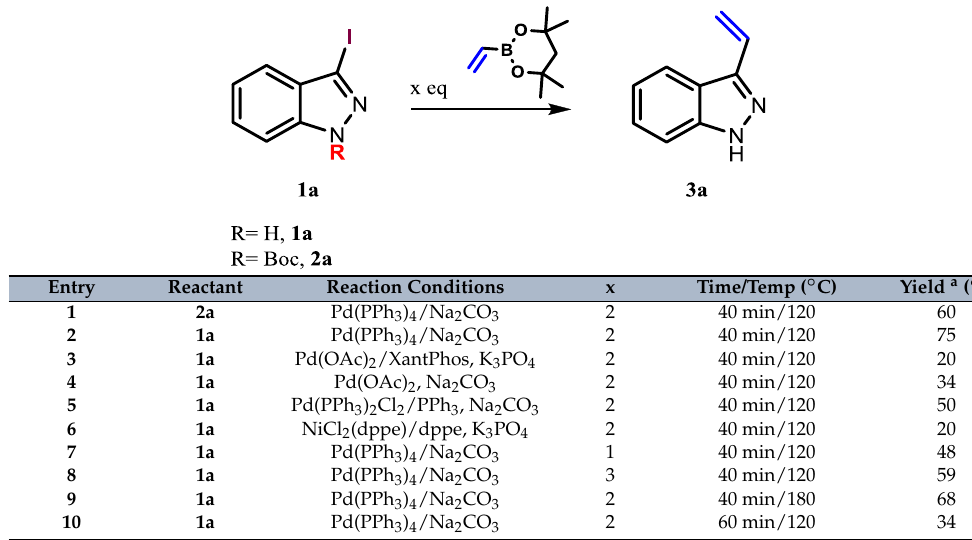
Table 1. Optimization of the reaction conditions.